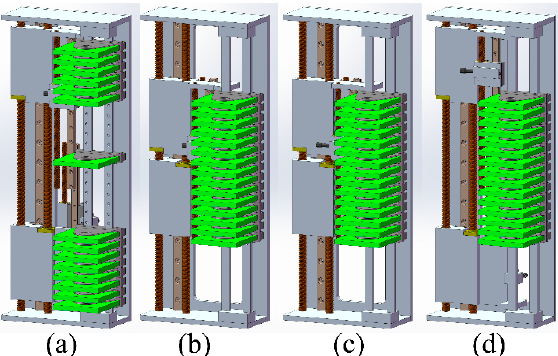
Figure 9. Shedding mechanism: the close shed process. ( a ) The shedding state; ( b ) sliding tables move to close shed; ( c ) locking devices unlock; ( d ) sliding tables and locking devices move to initial state.